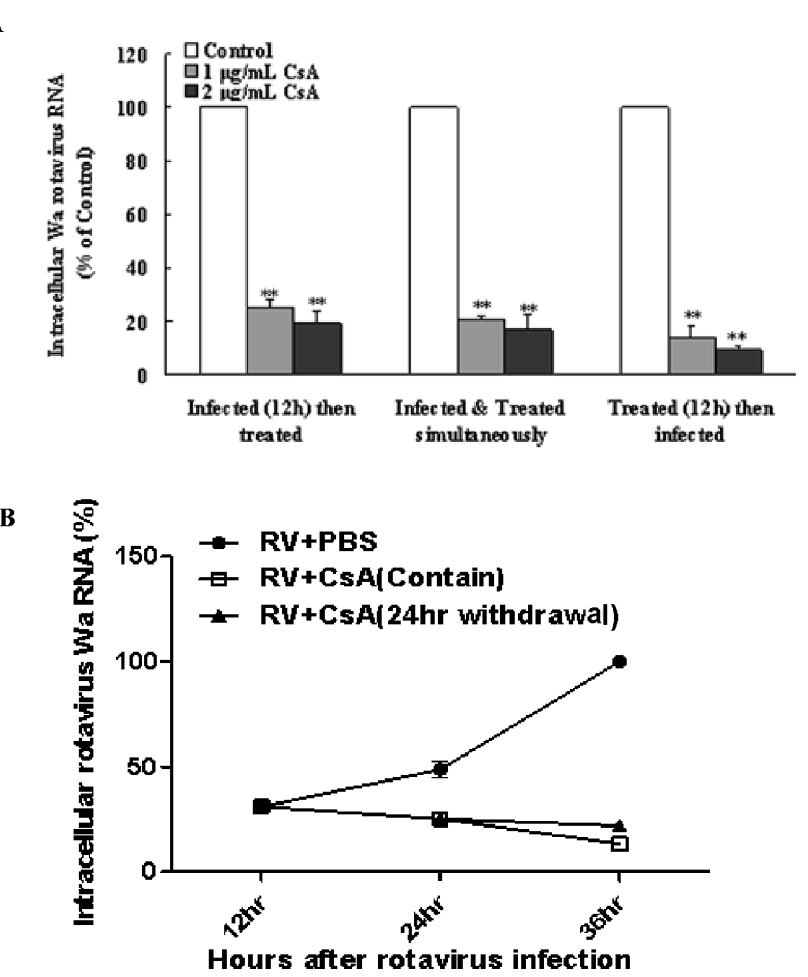
Figure 2. Effect of cyclosporin A (CsA) on Wa rotavirus infection and replication under various conditions. (A) Effect of different CsA treatment conditions on Wa rotavirus infection HT-29 cells, as follows: CsA treatment first for 12 h followed by Wa rotavirus infection for 24 h; simultaneous CsA treatment and Wa rotavirus infection followed by 24 h culture; or Wa rotavirus infection first for 12 h followed by CsA treatment for 24 h. Total cellular RNA extracted from the cell cultures was subjected to RT-PCR to quantify Wa rotavirus and GAPDH RNA. Intracellular Wa rotavirus RNA levels, normalized to GAPDH mRNA, are expressed as % of control (without CsA treatment, which is defined as 100). (B) Effect of CsA treatment withdrawal on Wa rotavirus replication. Control: HT-29 cells were infected with Wa rotavirus without CsA treatment; Maintain: Wa rotavirus-infected HT-29 cells were treated with CsA for 12 h, then cells were then cultured for additional 12 h in the presence of CsA; Withdrawal: Wa rotavirus-infected HT-29 cells were treated with CsA for 12 h, then cells were then cultured for additional 12 h in the absence of CsA. Intracellular Wa rotavirus RNA levels, normalized to GAPDH mRNA, are expressed as % of control (without CsA treatment, which is defined as 100 at 36 h post-infection). Data shown are expressed as mean 6 standard deviation of triplicate cultures, and 3 independent experiments were carried out (* P , 0.05, ** P ,